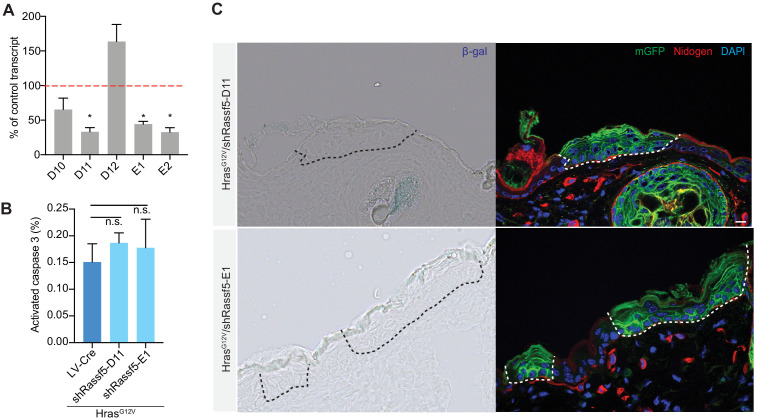
Rassf5 depletion does not induce apoptosis or senescence in Hras G12V epidermal clones.(A) Real-time PCR quantification of Rassf5 transcripts from cultured keratinocytes. Asterisks mark shRNAs that demonstrate efficient Rassf5 knock down and were used in additional experiments. Statistics were based on three experiments. (B) Quantification of caspase 3+ cells in adult epidermis. >1500 cells were counted per animal. n = 3 animals per genotype. (C) Senescence-associated β-galactosidase staining does detect senescence in oncogenic tissues with Rassf knockdown. For (A,B), the center line represents the mean and errors bars the s.d. Two-tailed Student’s t-test was used. n.s. denotes p value > 0.05; * denotes p value < 0.05.